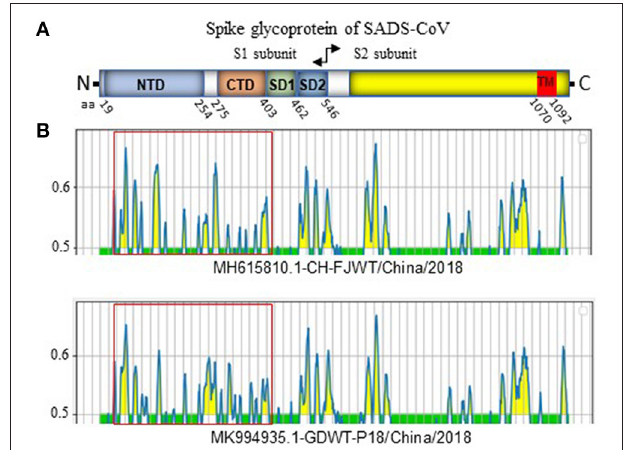
FIGURE 3 | Linear B cell epitope map of full-length S glycoprotein of indicated SADS-CoVs. (A) Diagram depicting the main features of SADS-CoV S glycoprotein, which include putative cleavage site between S1 and S2 subunits at aa 546, N-terminal domain (NTD) (aa 19-254), C-terminal domain (CTD) (aa 275-402), SD1 (aa 403-461), SD2 (aa 462-546), and the transmembrane domain (TM, aa 1070-1092). Numbers indicate the amino acid position relative to S glycoprotein of CH/FJWT/2018 strain (GenBank accession number: MH615810.1). (B) The linear B cell epitope map was generated by using BepiPred-2.0 server (19). Amino acid residues with scores above the threshold value that was set at 0.5 were predicted to be part of an epitope and colored in yellow on the graph. Y-axes depicts residue scores. X-axes depicts the amino acid positions, which is also relative to the diagram on the top (A)